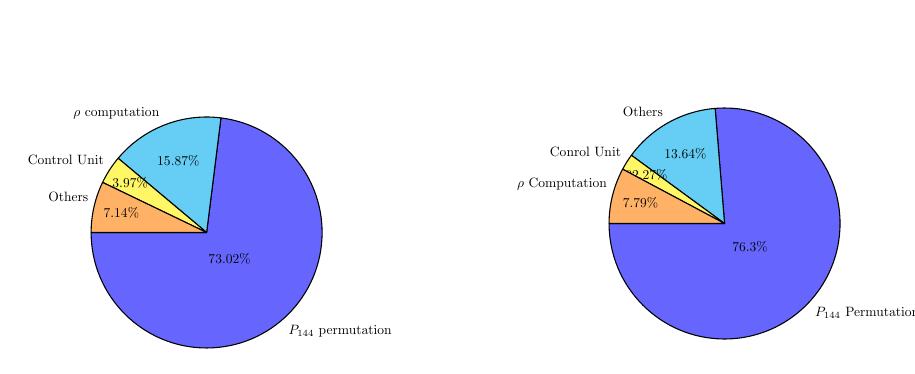
Figure 6: Distribution of Components by #Slices (left) and #LUTs (right)